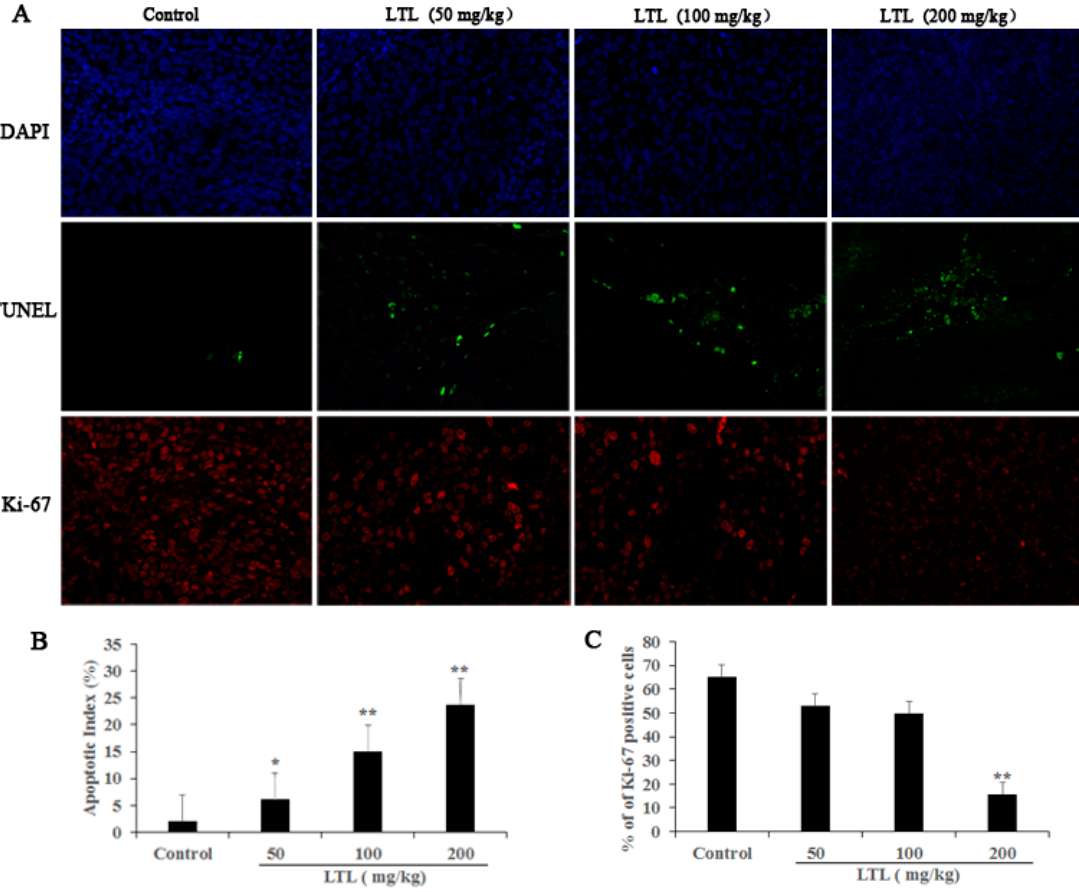
Figure 4. The effect of LTL on tumor cell apoptosis and proliferation in vivo. Paraffin sections of tumor tissue were tested by TUNEL (terminal deoxynucleotidyl transferase dUTP nick end labeling) and Ki-67 staining analysis. ( A ) TUNEL-positive cells (green) and Ki-67-positive cells (red) were observed under a fluorescence microscope (×400). Nuclei were counter-stained with DAPI (blue); ( B ) The apoptotic index was calculated as the number of TUNEL-positive cells for each group; ( C ) Quantification of Ki-67-positive cells is represented as the ratio of Ki-67-positive cells to the total number of cells for each group. The results are expressed as means ± SD of three independent experiments. * p < 0.05, ** p < 0.01, compared with the controls.